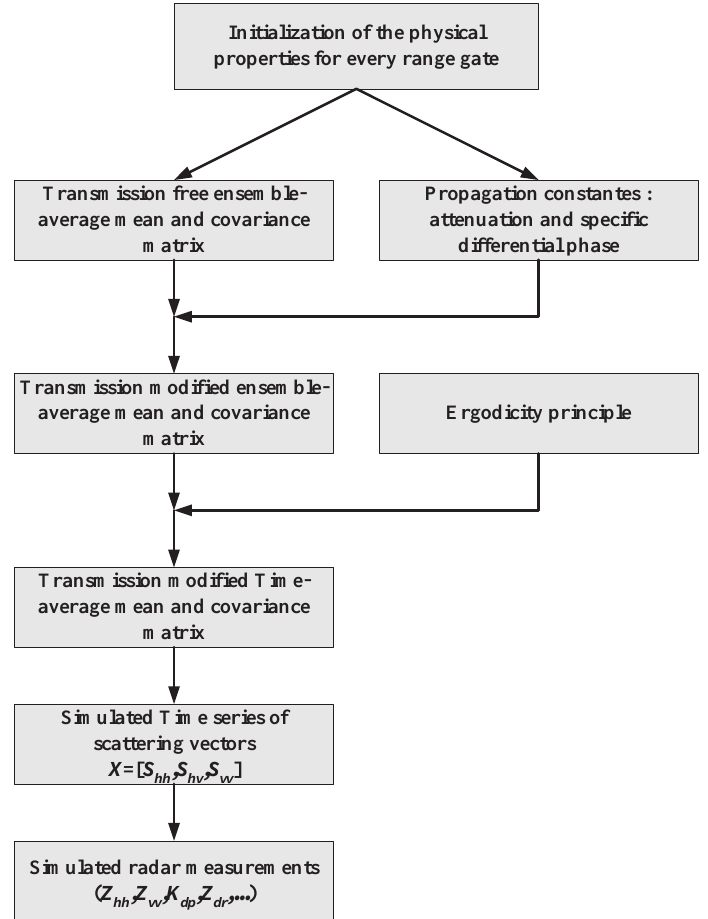
Fig. 2. The block diagram for the principle of the proposed data